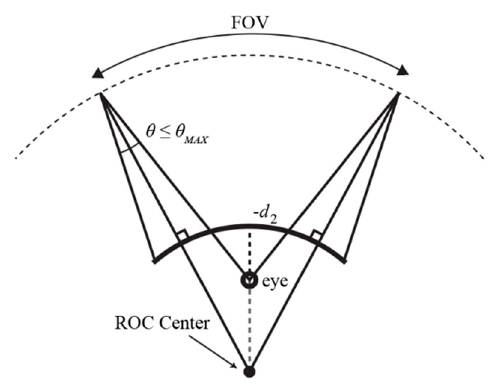
Figure 10. A display with a radius of curvature (ROC) placed behind the eye will have some angular view that the eye can perceive. The point (on either side of the eye) at which this no longer is true is where the furthest ray towards the eye no longer falls on the